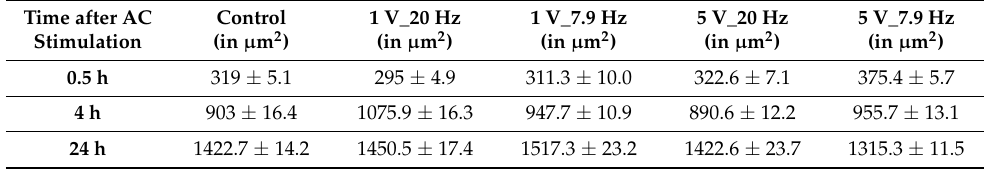
Figure 10. Influence of AC electrical stimulation (ES, 10 min) on MG-63 cell morphology and spreading at 0.5, 4, and 24 h. ( a ) Scanning electron microscopy of cells. Note that ES does not influence the overall cell shape. Cells start to spread at 0.5 h, which is typical for MG-63s. (FE-SEM Merlin compact, Carl Zeiss, 500 × , scale bars = 10 µ m). ( b ) Cell area analysis. Note that the different AC-stimulation settings have no significant impact on the time-dependent spreading compared to unstimulated control cells (Control). (ImageJ, n = 40 cells, median ± min/max; one-way ANOVA posthoc uncorrected Fisher’s LSD, * p < 0.05). Table 2. Cell area values of 10 min AC-stimulated MG-63 osteoblastic cells (mean ±